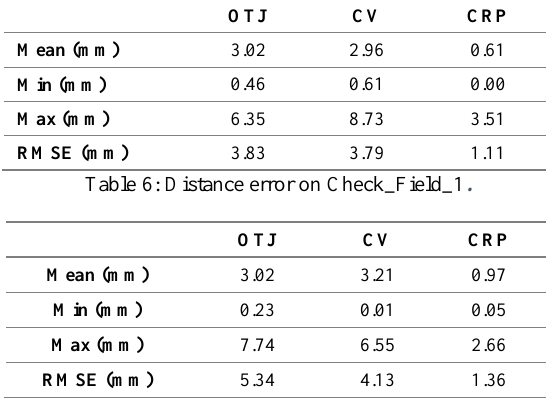
Table 7: Distance error on